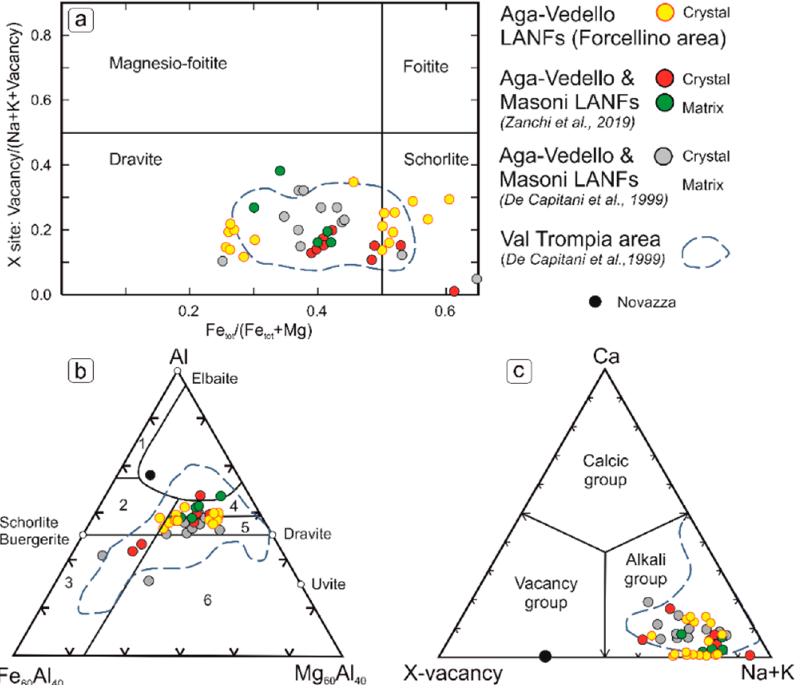
Figure 10. ( a ) xFe vs X-site alkali occupancy diagram: all analysed tourmaline and tourmalinites plot below the foitite-dravite divide. Tourmalines from the Forcellino Pass area display a clear zoning with Mg-rich cores and Fe-rich rims. The dashed blue line indicates the compositional field of tourmaline from the Trompia Valley area. ( b ) Fe-Mg-Al diagram [55]. The compositions are within field 4 and 5, typical of tourmalinites in metapelitic and metapsammiti rocks. ( c ) Classification diagram based on the principal constituent at the X-site [53]; all tourmalines from all the considered areas plot within the Alkali group field.